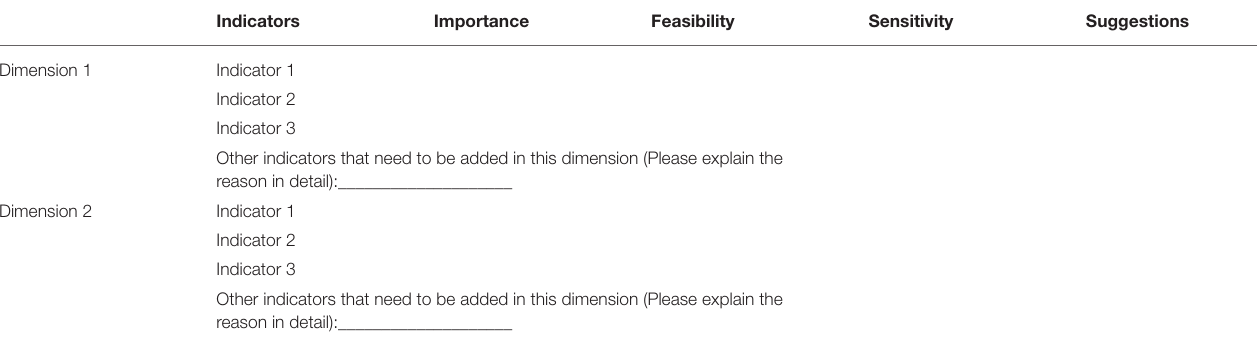
TABLE 1 | Example of the Delphi